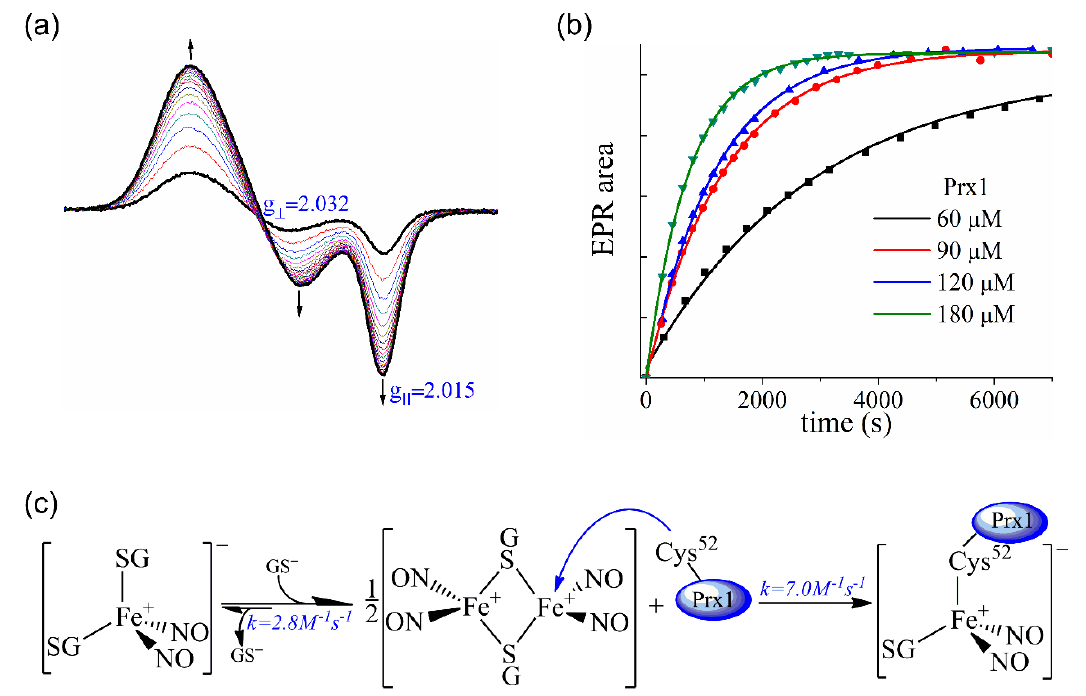
Figure 6. Prx1 Cys 52 binding to DNIC ( a ) Representative changes in the EPR spectrum with time for the reaction between Prx1 (180 μ M) and DNIC-GS (60 μ M). ( b ) EPR signal area vs. time for the reaction between DNIC-GS (60 μ M) and Prx1 (60-180 μ M). All the incubations and spectra were performed in phosphate buffer (50 mM) containing DTPA (0.1 mM), pH 7.4 (final) at 25 °C. ( c ) Schematic representation of the reaction between Prx1 peroxidatic Cys and DNIC-GS.